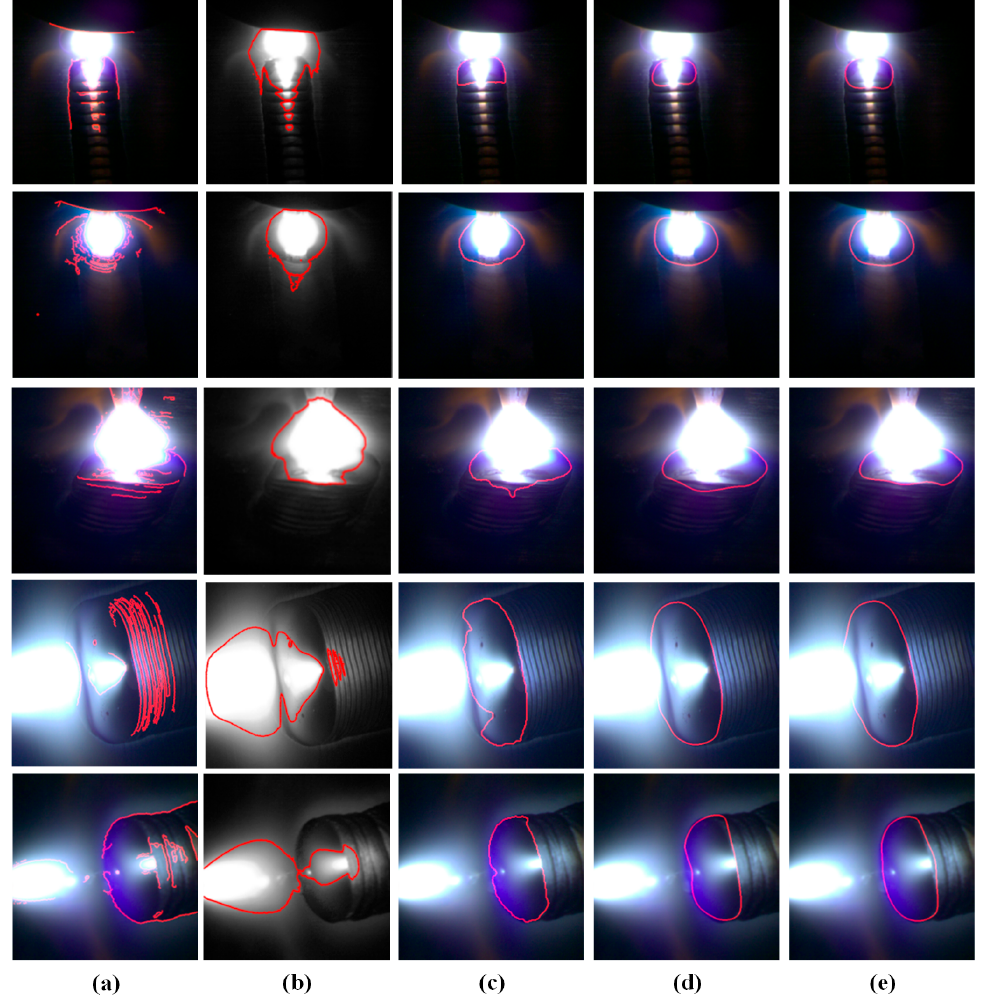
Figure 10. Test result of test data set: ( a ) Canny; ( b ) Chan-Vese (CV) model; ( c ) ENet; ( d ) Res-Seg; ( e ) Res-Seg + DCGAN.